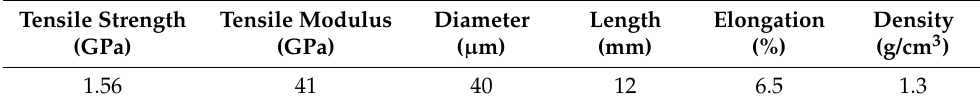
Table 2. Properties of PVA